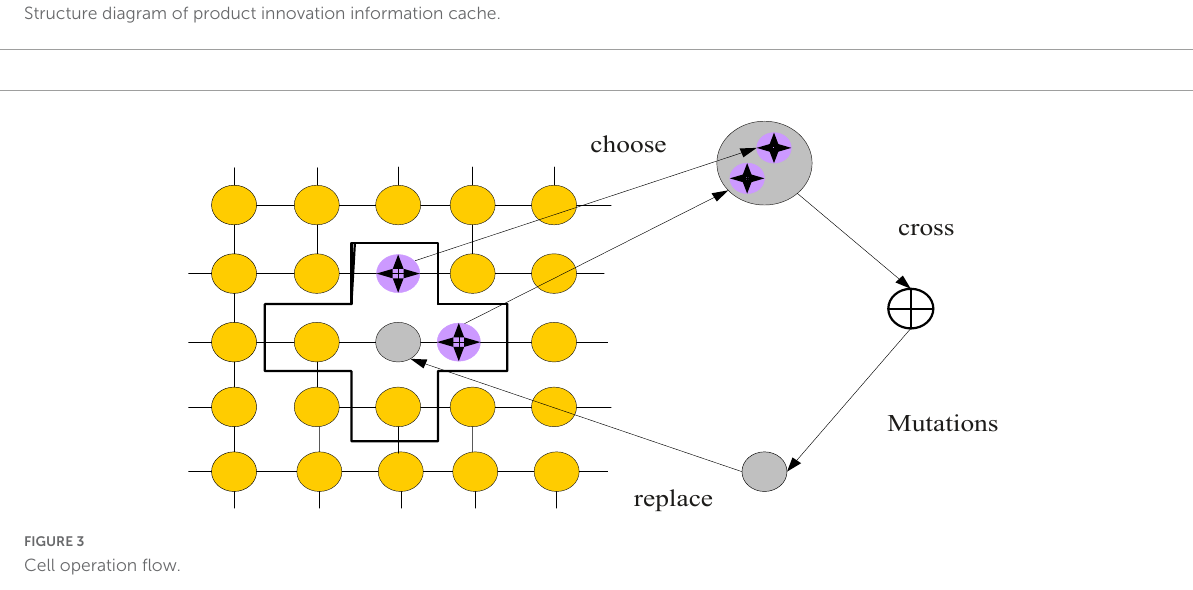
FIGURE2 Structure diagram of product innovation information cache.